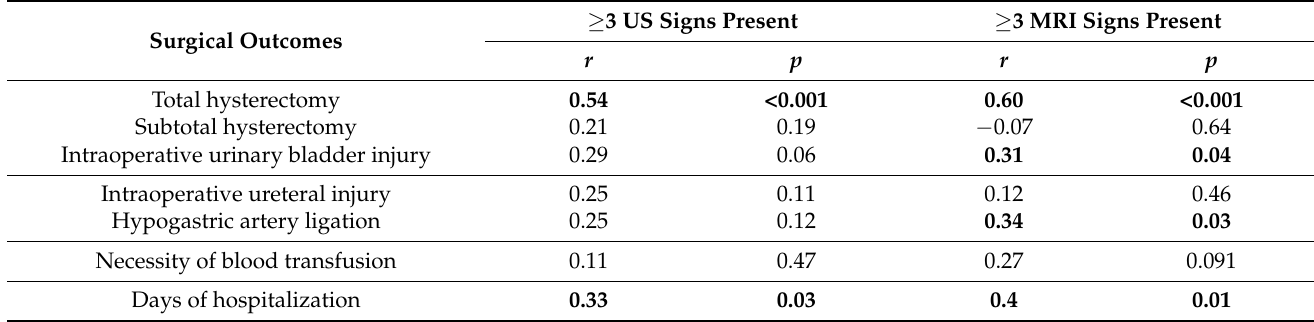
Table 8. Correlation between the number of US and MRI signs and surgical